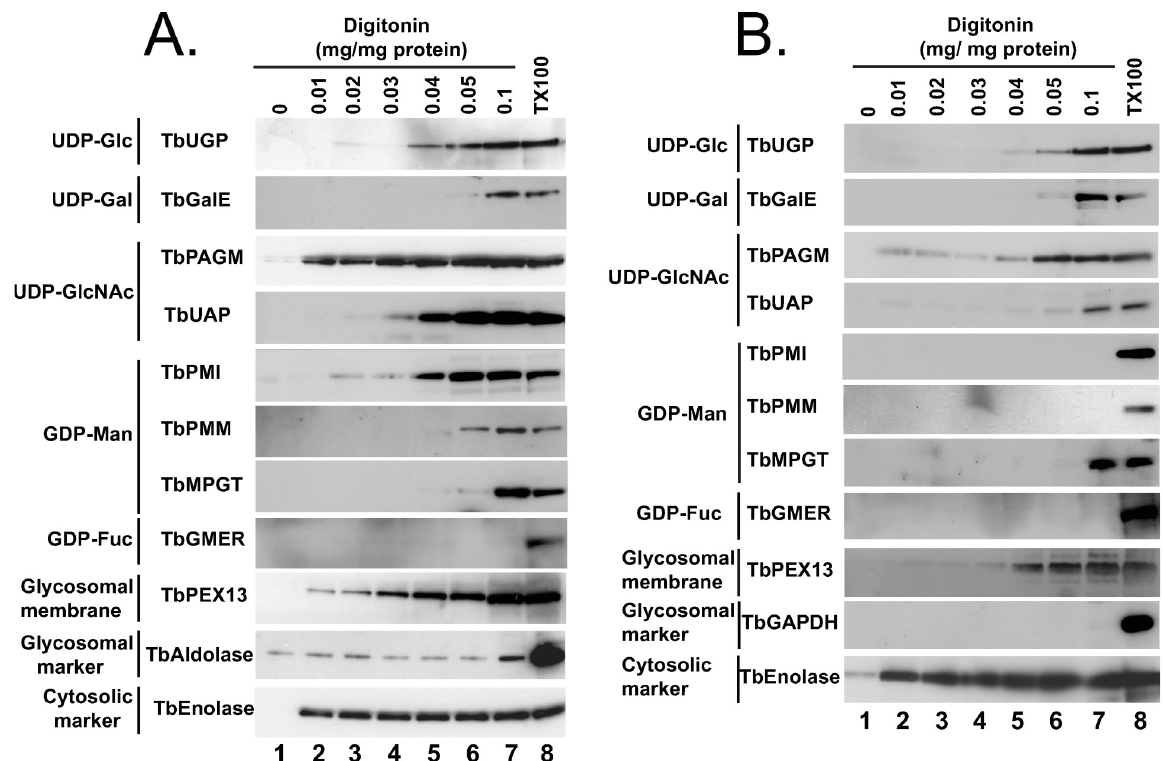
Fig 5. Digitonin latencies of nucleotide sugar biosynthetic enzymes in bloodstream and procyclic forms of T . brucei . Trypanosomes (bsf, panel A; pcf, panel B) were treated with increasing concentrations of digitonin (0.01 to 0.1 mg digitonin per mg trypanosome protein) and with no detergent and 0.1% TX100 as controls for no cell permeabilization and total cell and glycosome membrane permeabilization, respectively. The release of the cytoplasmic marker TbEnolase at the lowest digitonin concentration is consistent with the selective permeabilization of the plasma membrane over the glycosome membrane. The release of TbAldolase (panel A) or TbGAPDH (panel B) at higher digitonin concentrations, or only with 0.1% TX100, i.e., showing latency, is consistent with their known glycosome lumen locations. From the patterns of digitonin latency of the nucleotide sugar biosynthetic enzymes, we conclude that all shown, except TbPAGM, are principally or exclusively protected against release by digitonin by being sequestered in a low-sterol intracellular membrane-bound compartment.